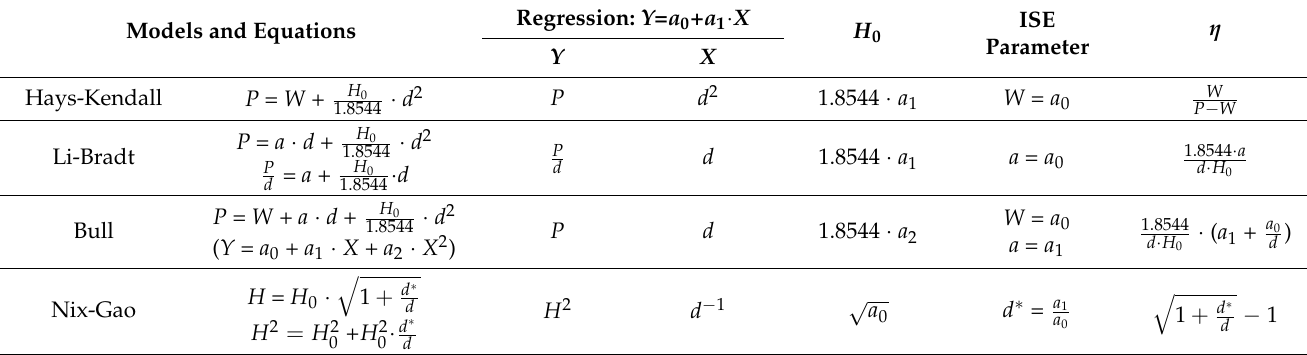
Table 1. The regression analysis to calculate the real hardness H 0 and ISE significance coefficient η